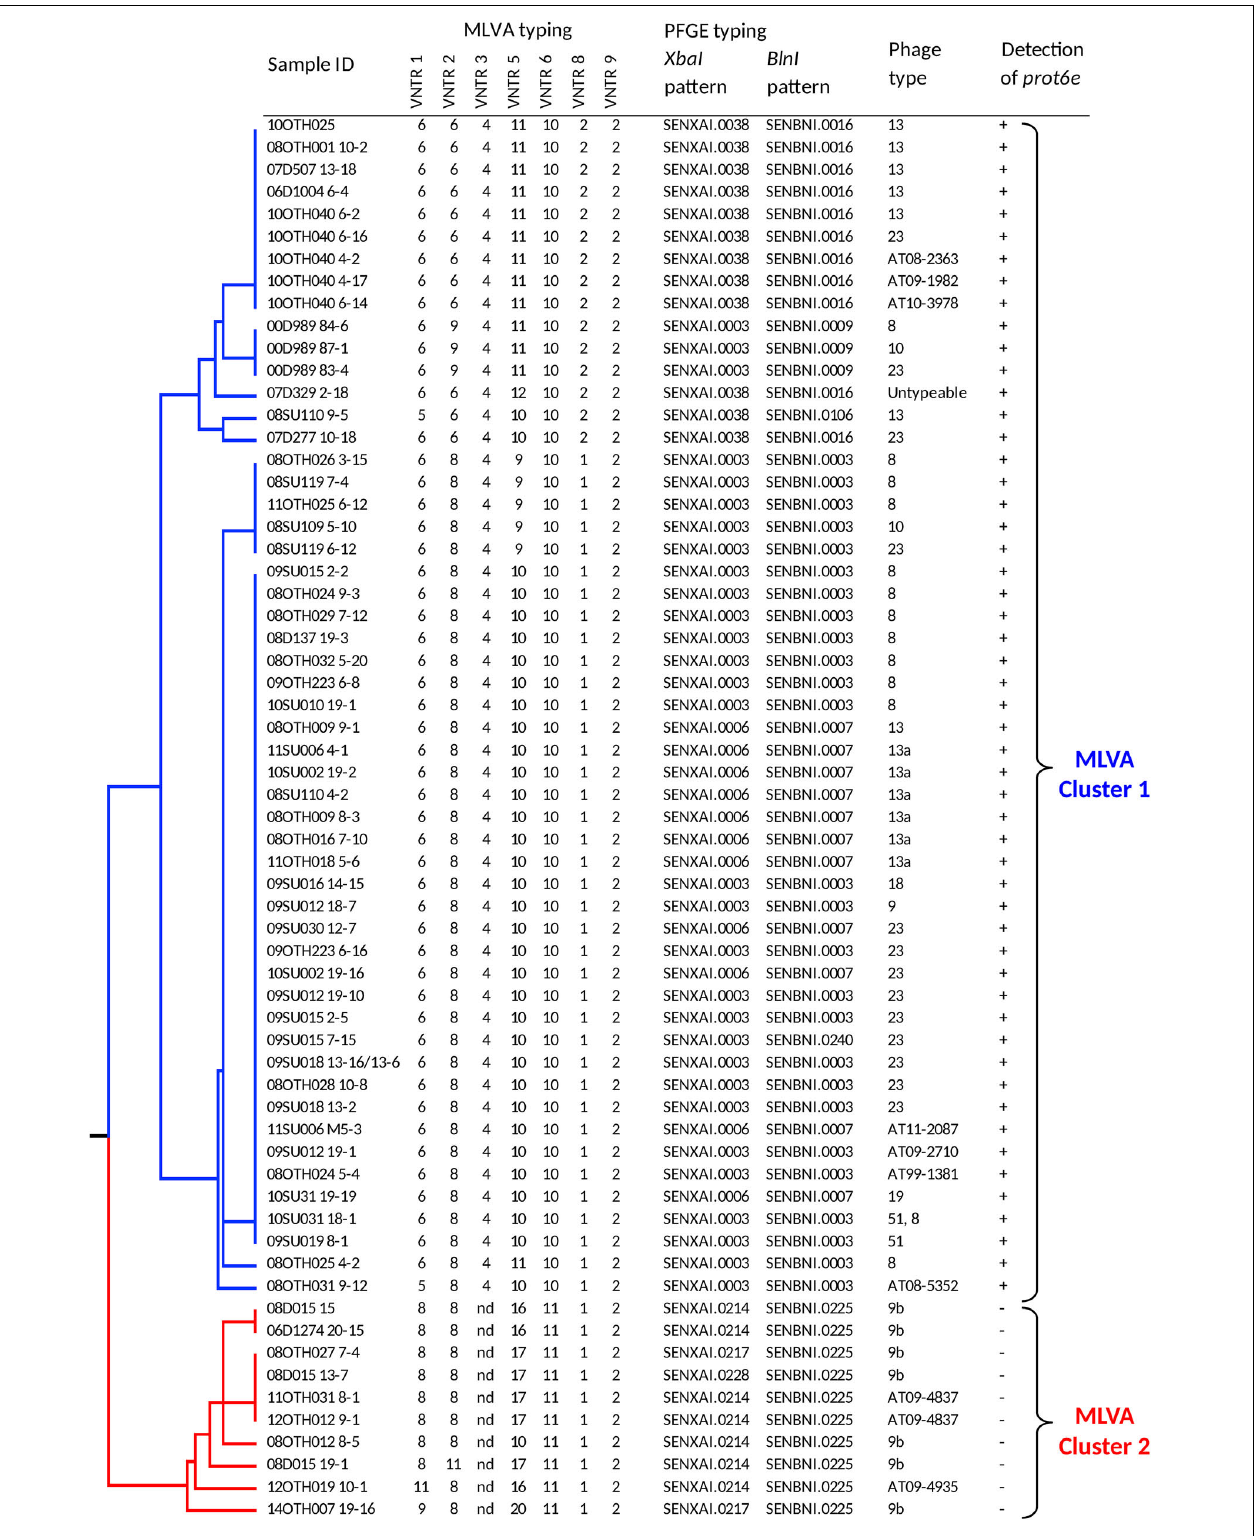
FIGURE 1 | Dendrogram representing genetic relationships among 63 S . Enteritidis based on MLVA profiles. The table to the right of the dendrogram shows isolate IDs, the allelic pattern for each MLVA profile, PFGE and phage types, and presence of the prot6e gene. Division of the samples into two very distinct MLVA clusters, 1 (blue) and 2 (red), is indicated to the